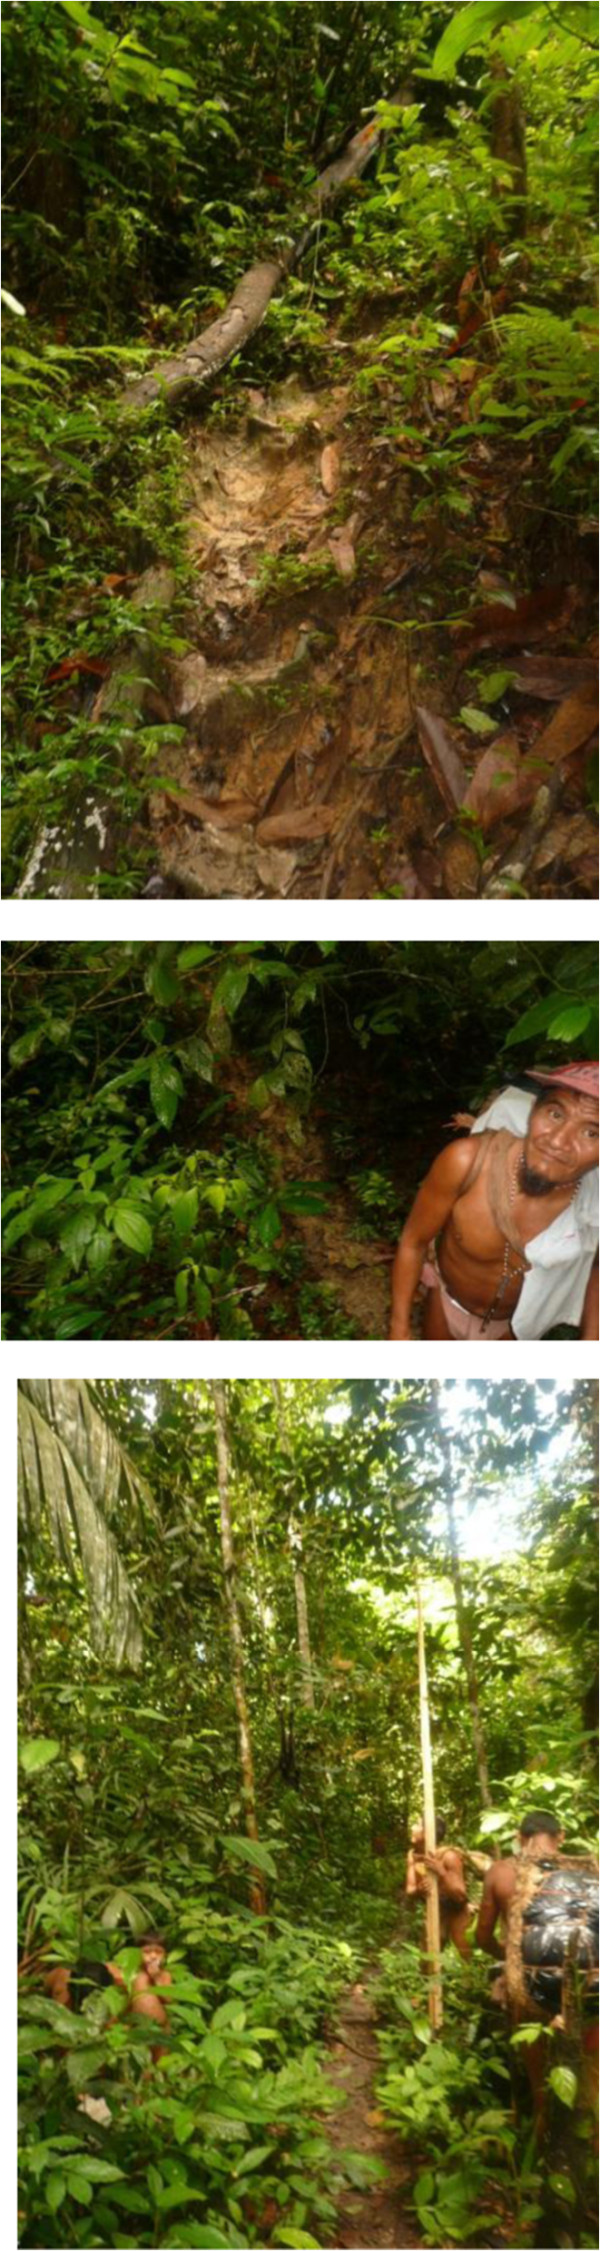
Typical Jotï trail.